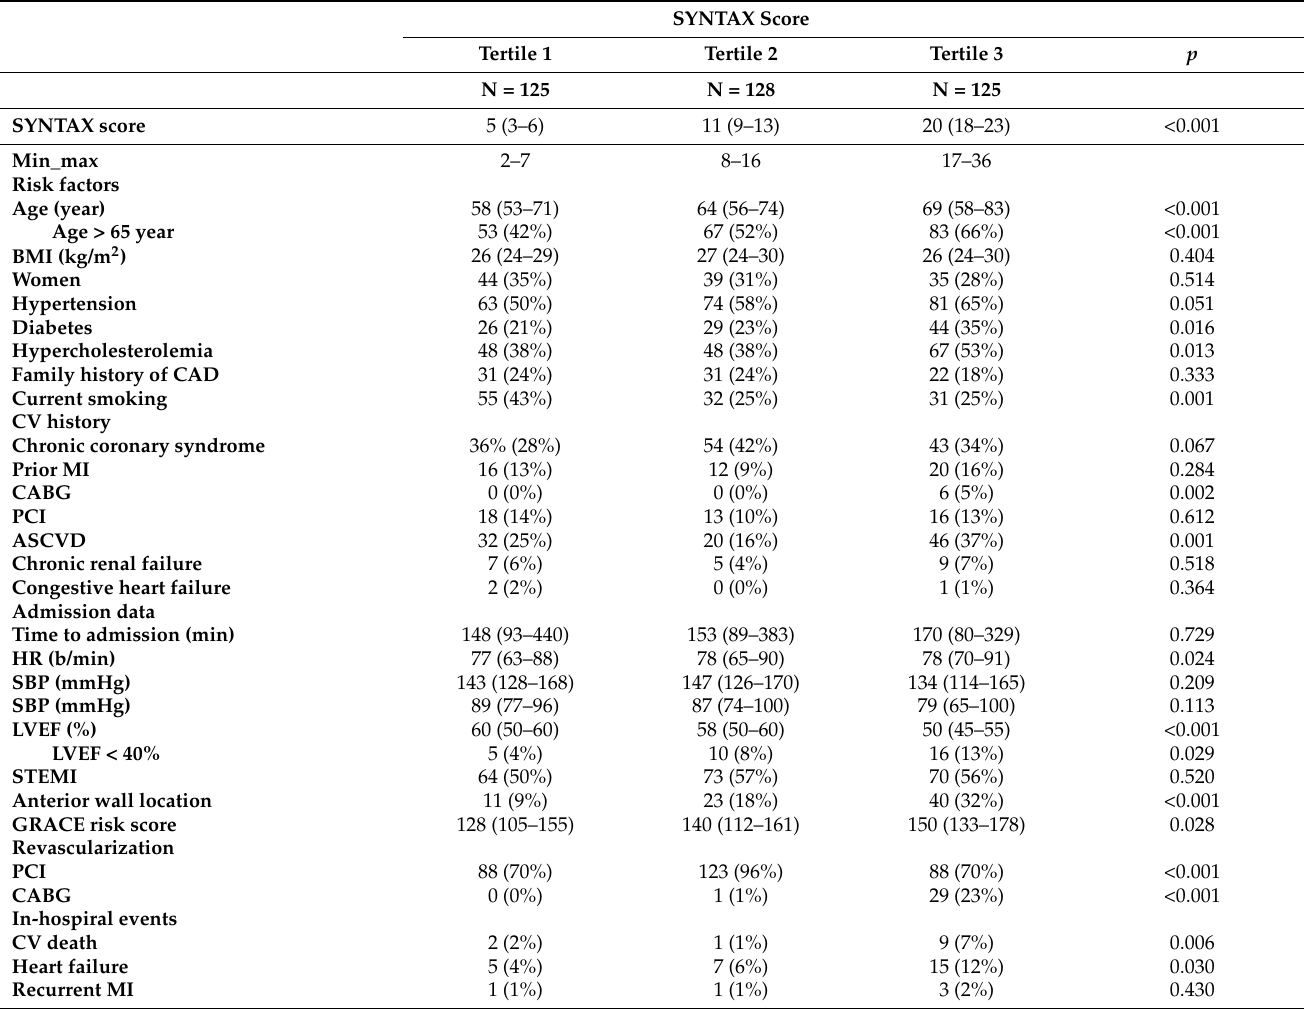
Table 1. Baseline characteristics, according to SYNTAX score tertiles. n (%) or median